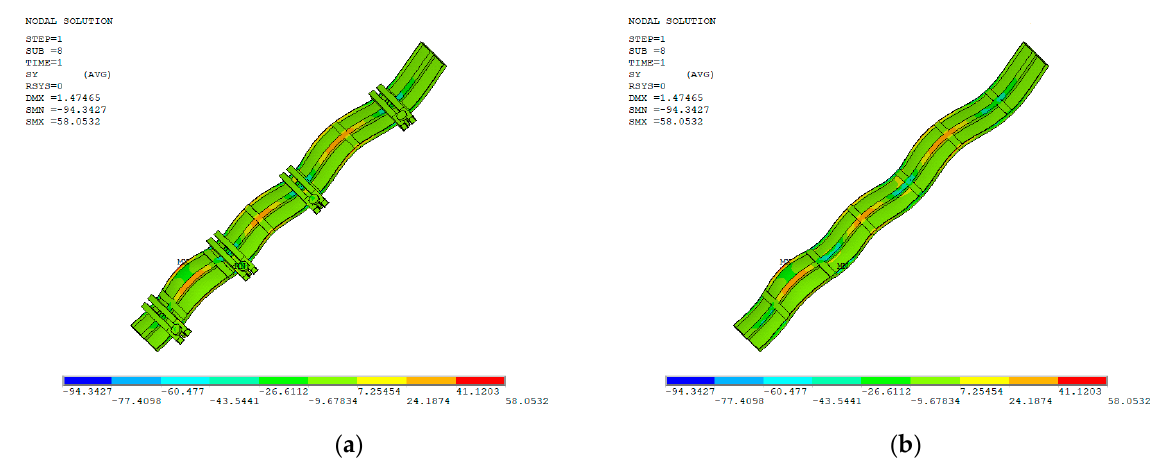
Figure 12. Stress nephogram along Y -direction: ( a ) outside view; ( b ) inside view. Compared to the stress along the X -axis, the stress along the Y -axis was relatively uniform with little change. The maximum tensile stress of 58.0 MPa appeared in the middle of the edge rib between the first and second braces, while the maximum com- pressive stress of 94.3 MPa appeared on the edge rib of the formwork connected to the second brace. This indicates that the constraint effect of vertical ribs was prominent with a higher stress under lateral pressure of SCC. Compared to the stresses along X - and Y -axes, the Z -axis was parallel to the direction of lateral pressure. As presented in Figure 13, the maximum stresses all appeared in the contact surfaces between the bolt and brace, as well as between the brace and formwork. near the edge rib of the formwork contact with the second brace.